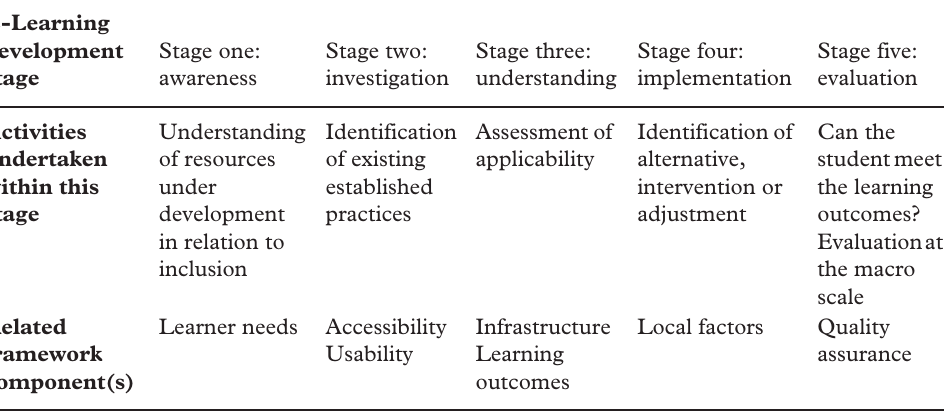
Table 1. Activities associated with applying the holistic framework to the e-learning development